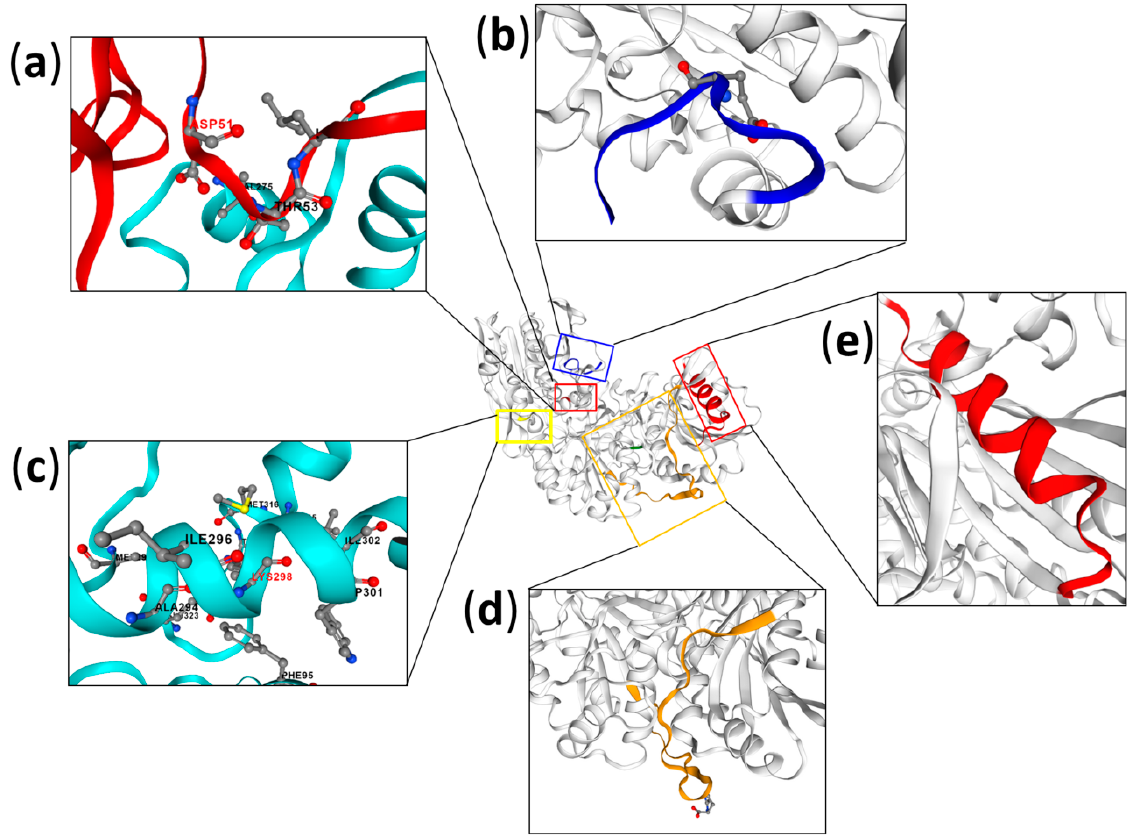
Figure 5. Key residues and structural features essential for thermoactivity and thermostability of thermo-ASNases. Structures are built in SWISS-MODEL (http://swissmodel.expasy.org/ accessed on 13 January 2023). ( a , c ) “Special residues” of thermo-ASNase P. yayanosii (PyA)—D51 and K298, respectively. ( b ) C-terminal residues of PyA. ( d ) Linker and β -strand residues L179-V-V-N182 of the N-terminal domain of thermo-ASNase from P. furiosus . ( e ) α 3 secondary structure of PyA thermo-ASNase. Table 2. Amino acid residues affected thermoactivity and thermostability of thermo-ASNases [59,98].